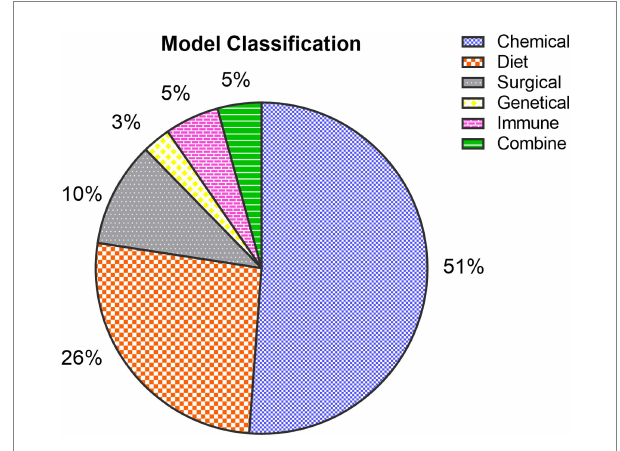
FIGURE 3 Classification of fibrosis models: Among the collected articles, 1,289 (51%) were chemically induced models, 661 (26%) were diet-induced models, 258 (10%) were surgically induced models, 69 (3%) were transgene-induced models, 133 (5%) were immune-induced models, and 108 (5%) were combine-induced animal models.